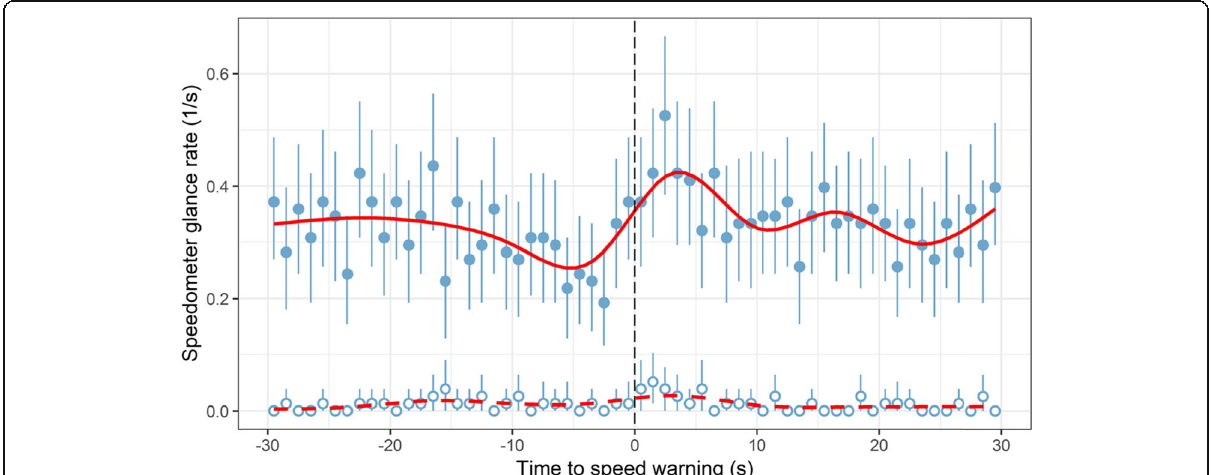
Fig. 7 Speedometer glance rates before and after speed warnings, calculated in one-second bins over all the speed warnings. Mean and 95% CI shown with points and ranges, with loess smoothed solid red line. For comparison, speed app glance rates similarly on the bottom (the circles with ranges, with loess smoothed dashed red line)